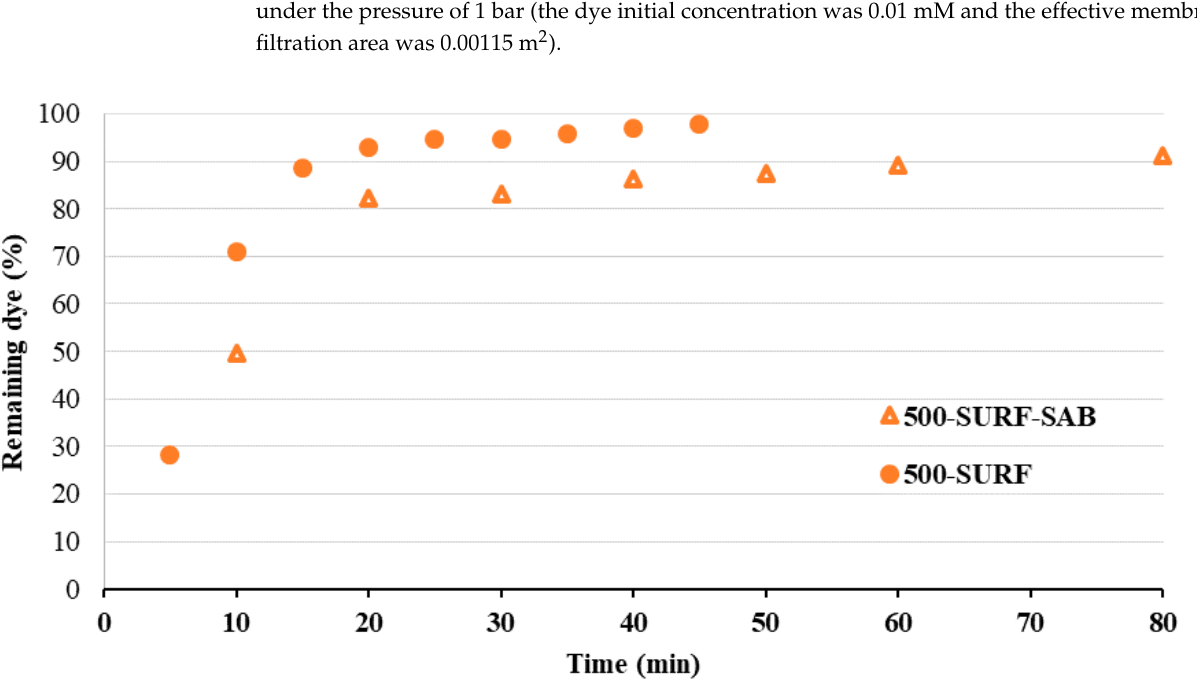
Figure 9. MO remaining dye (%) for a solution flowed through the membranes 500-SURF and 500- SURF-SAB under the pressure of 1 bar (the dye initial concentration was 0.01 mM and the effective membrane filtration area was 0.00115 m 2 ).